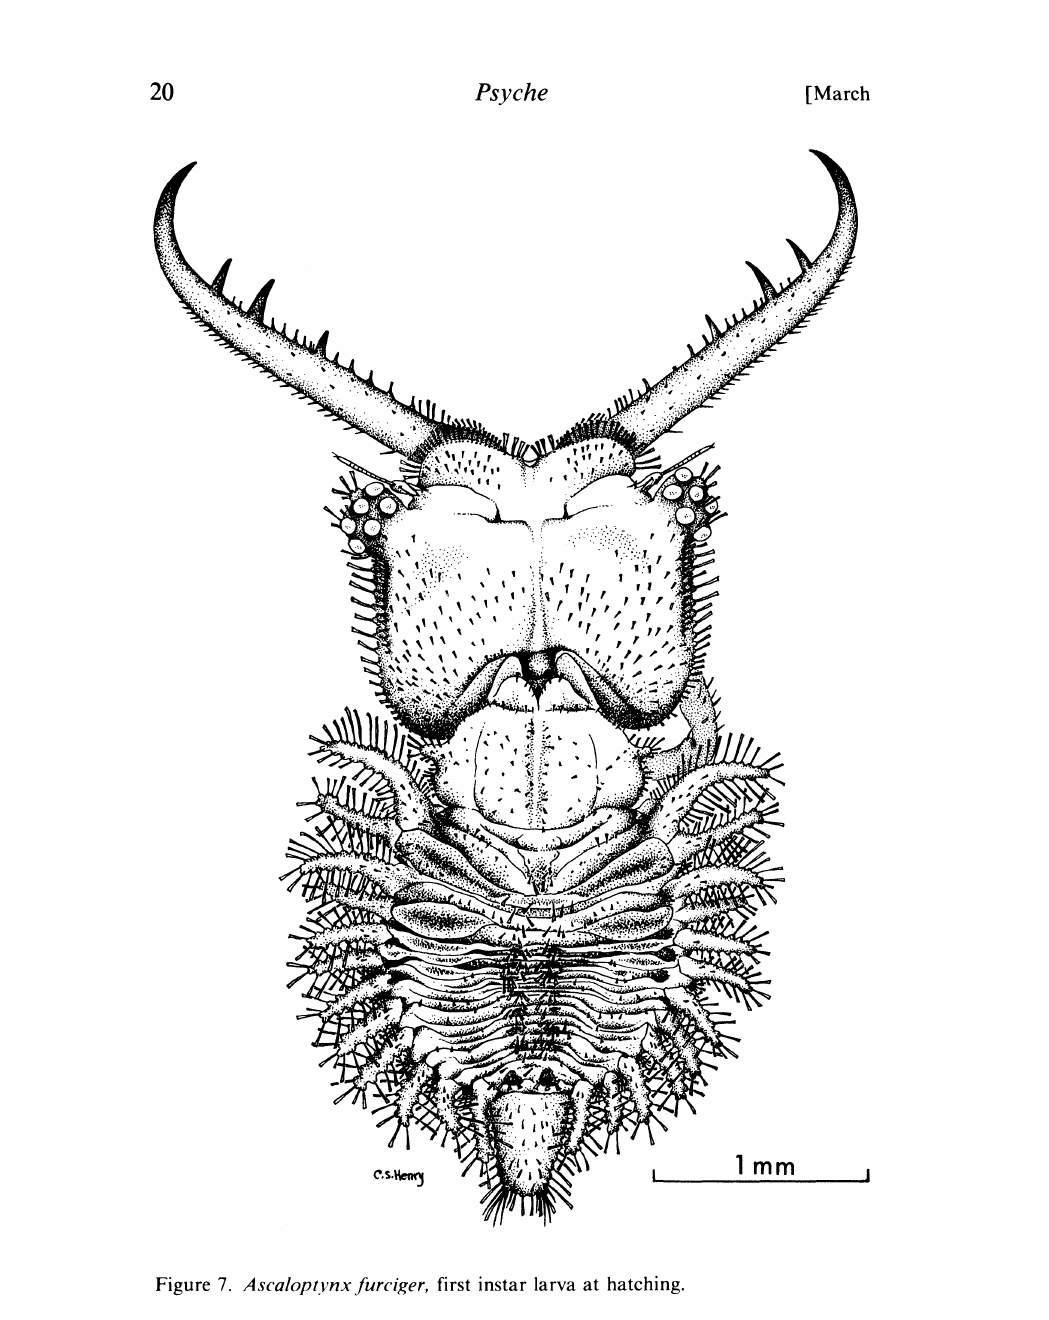
Figure 7. Ascaloptynxfurciger, first instar larva at